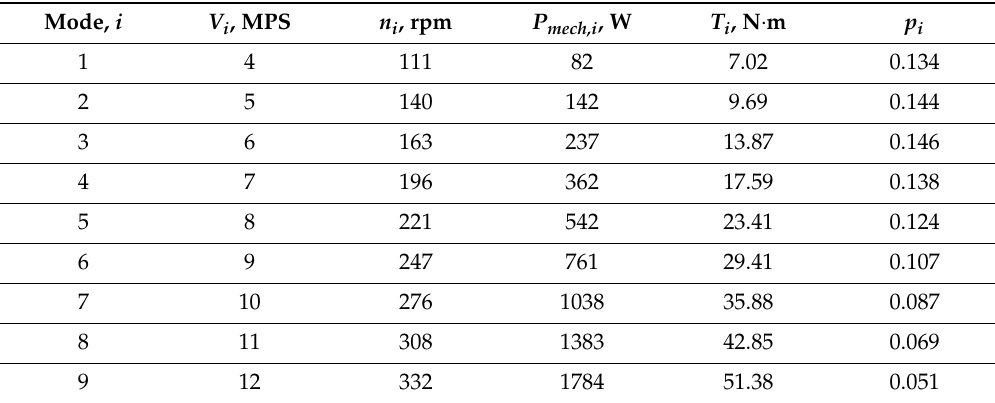
Table 1. The operating points of the wind generator.